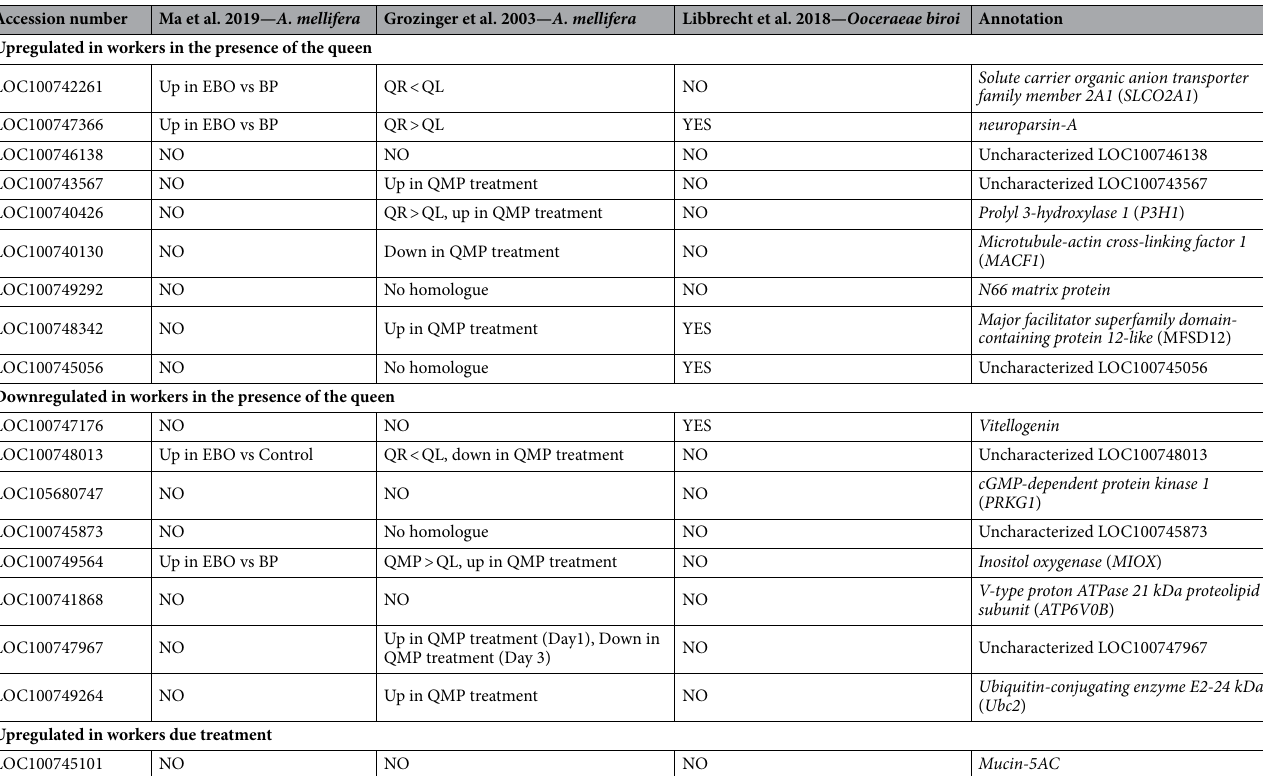
Table 1. Comparison of the 18 differentially expressed genes (DEGs) identified in the current study with three similar data sets. Grozinger et al. 28 compared DEGs in Apis mellifera worker’s brain of three treatments: in the presence of the queen, in its absence, and when exposed to queen mandibular pheromone (QMP); Ma et al. 52 compared DEGs in A. mellifera worker’s brain exposed to two different brood pheromones (EBO and BP); and Libbrecht et al. 51 compared DEGs in the brain of workers of the clonal raider ant Ooceraea biroi in the reproductive stage (absence of young larvae) and the non-reproductive stages (presence of young larvae). An overlap between the DEGs identified in these studies and the current study was indicated in the table with yes/ no. Whenever data were available, we also provide the directionality of the expression.